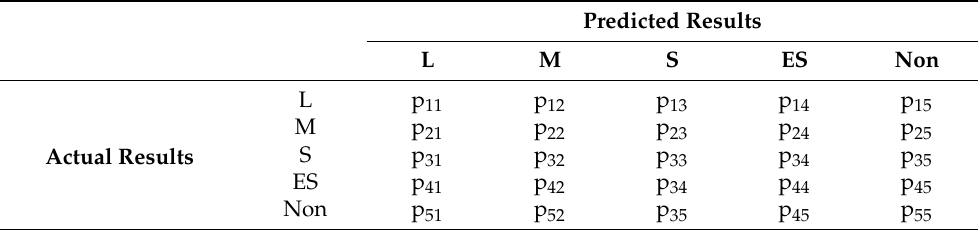
Table 2. The confusion